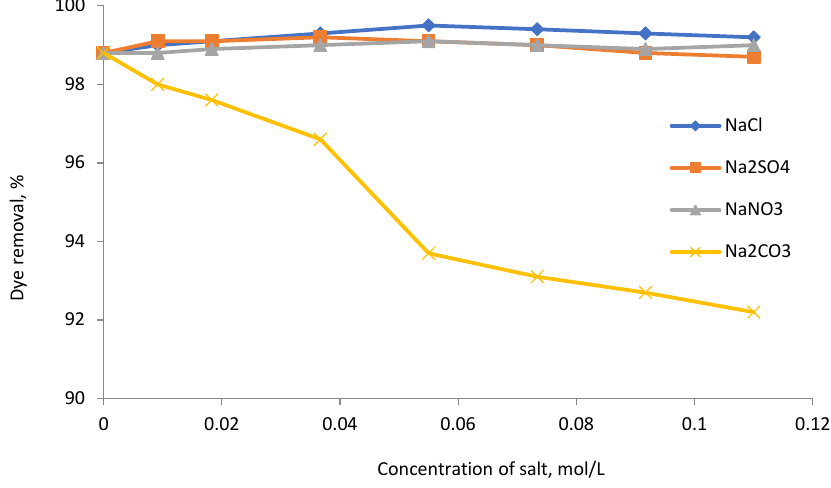
Figure 8. Effect of salt dosage on dye removal (100 mg/L RB5 dye solution, 110 mg/L lignin-METAC dosage (sample 4), pH 6, 30 °C).